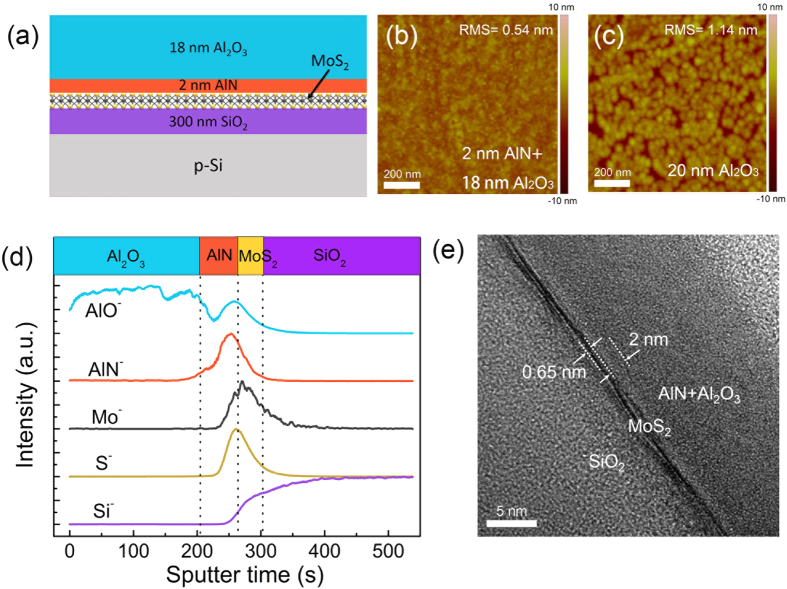
(a) Schematic of MoS2 sample after the deposition of AlN/Al2O3. (b) AFM image of MoS2 surface after the deposition of 2-nm AlN and 18-nm Al2O3. (c) AFM image of MoS2 surface after the direct deposition of 20-nm Al2O3. (d) Element distribution profiles from ToF-SIMS measurement and (e) Cross-sectional HRTEM image of the structure in (a).